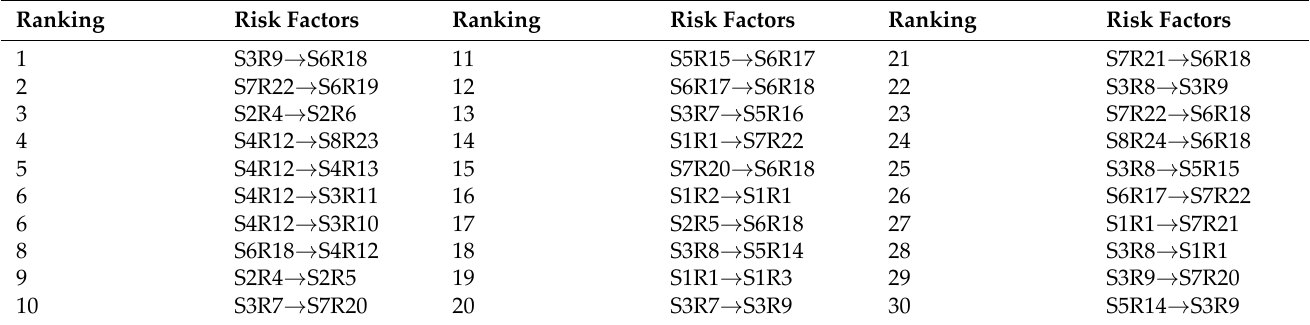
Table 6. Identification of key relationships in the top 30 risk network